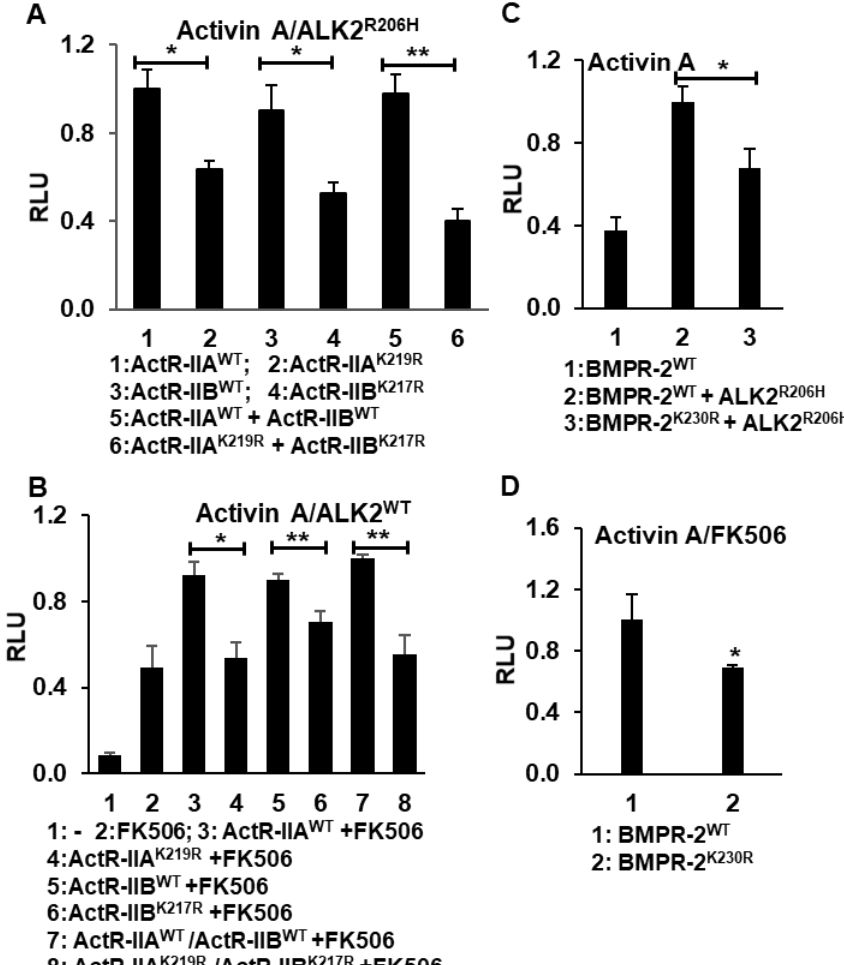
Figure 6. The type II receptor kinase activity is required in activin A-induced BMP signaling. ( A ) The overexpression of kinase-deficient ActR-IIA K219R and ActR-IIB K217R significantly downregulated activin A-induced BMP signaling via FOP ALK2 R206H . ( B ) The overexpression of kinase-deficient ActR-IIA K219R and ActR-IIB K217R significantly downregulated activin A-induced BMP signaling via ALK2 WT upon FKBP12 dissociation in HepG2BRA cells. ( C ) The overexpression of kinase-deficient BMPR-2 K230R downregulated activin A-induced BMP signaling via FOP ALK2 R206H and ( D ) via ALK2 WT upon FKBP12 dissociation. All the luciferase assays were conducted in the stably transfected BMP-responsive HepG2BRA cells. Results of the luciferase assay were represented as the mean relative luciferase units (RLU) ± SEM ( n = 3, * p < 0.05, ** p < 0.01).